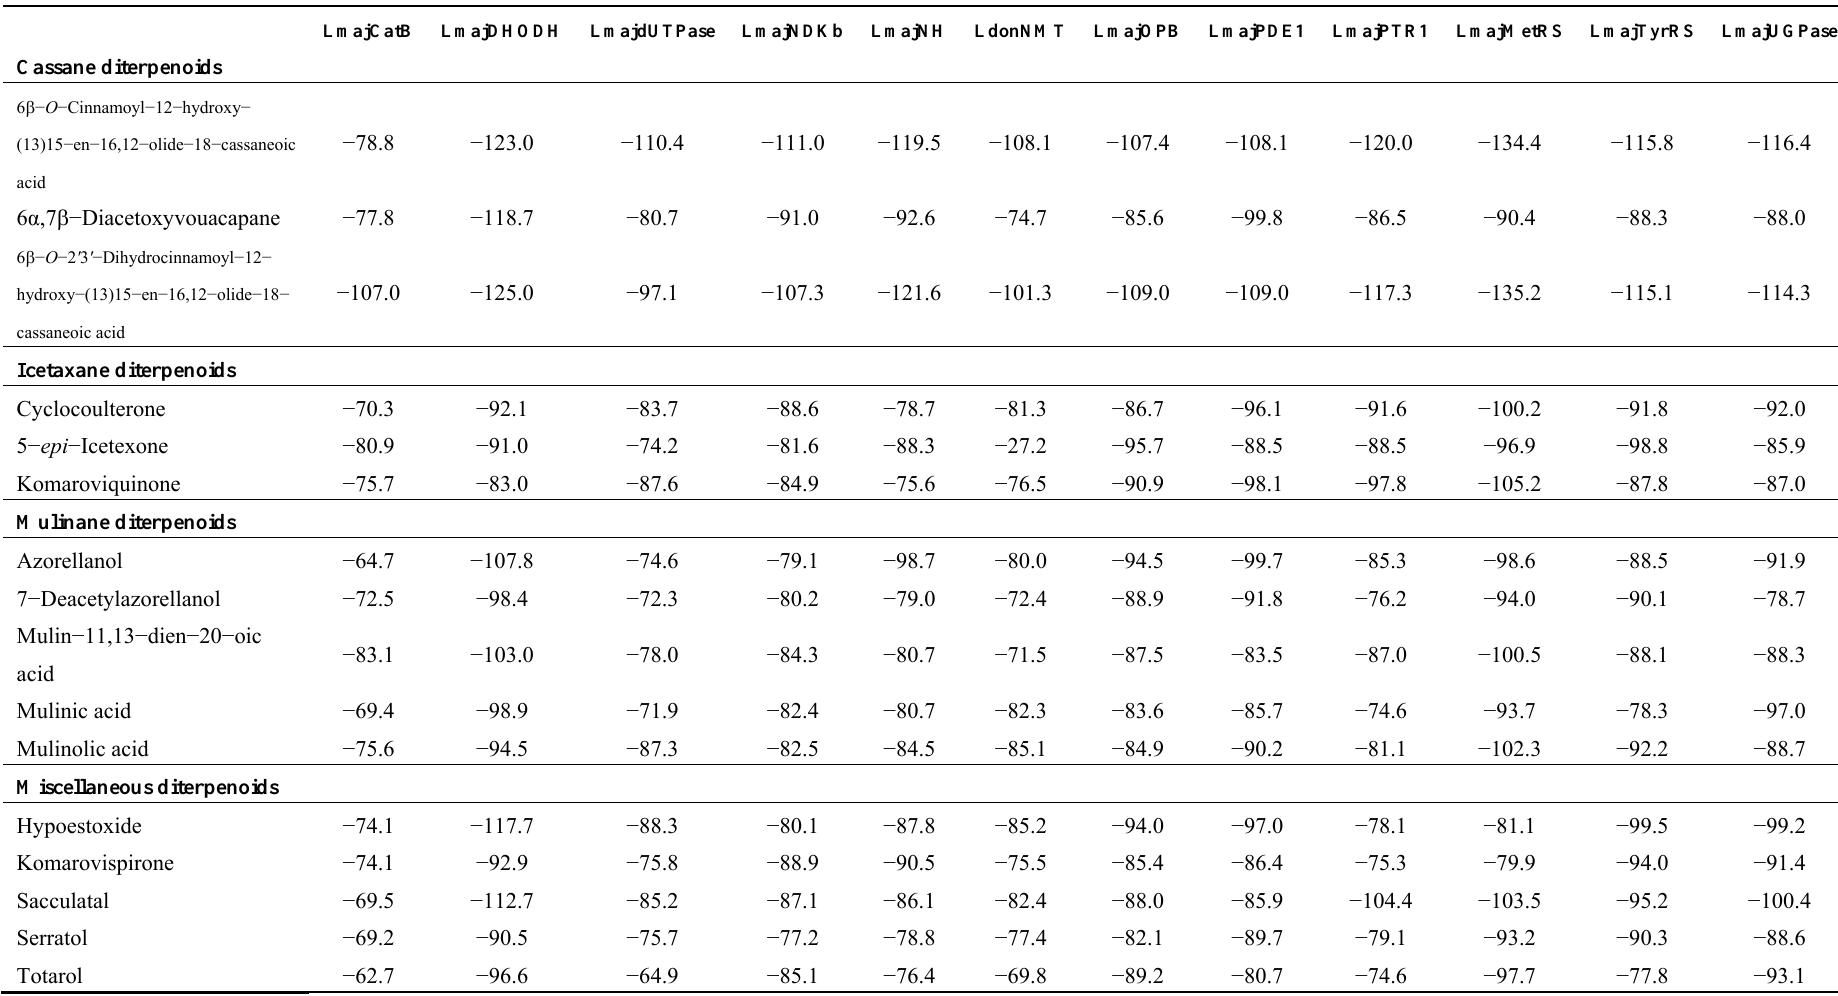
Table 26. MolDock docking energies (kJ/mol) of miscellaneous diterpenoids with Leishmania major protein